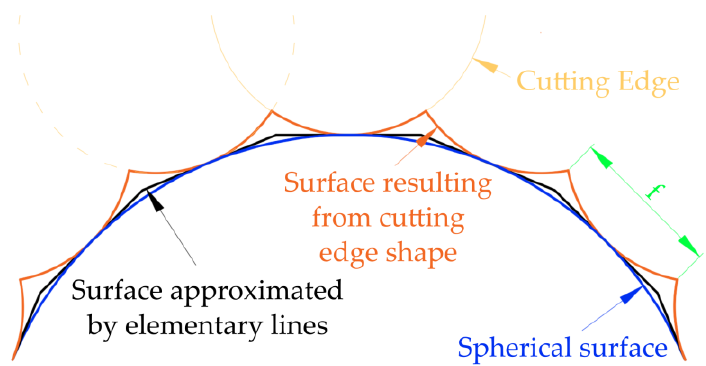
Figure 2. Shape changes of undeformed chip area A t for different feed rate f and surface tilted angle δ .